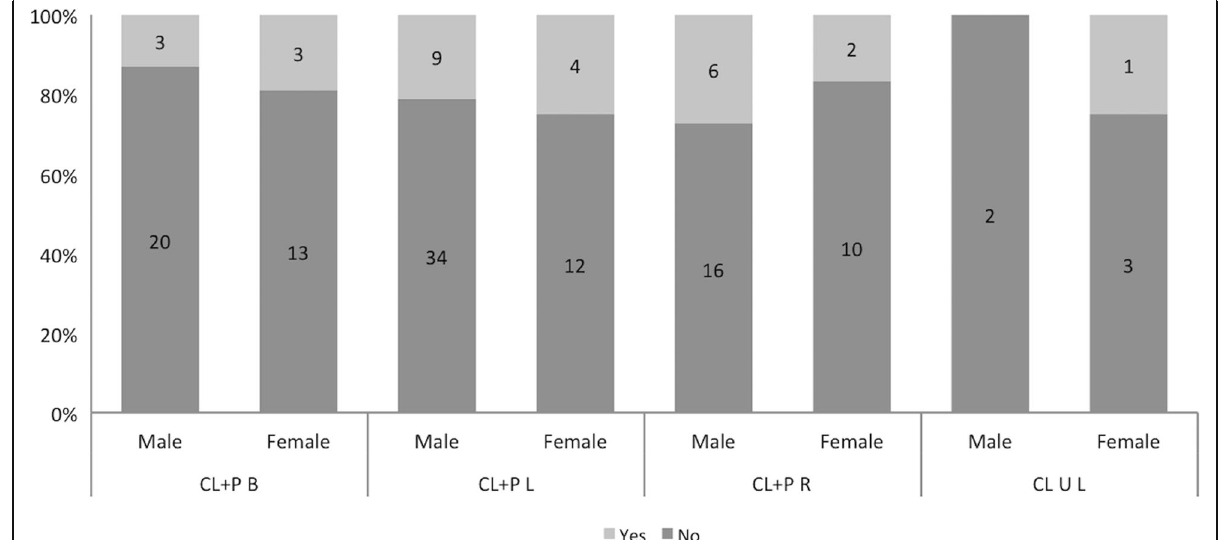
Fig. 3 Microdontia by gender and cleft among 138